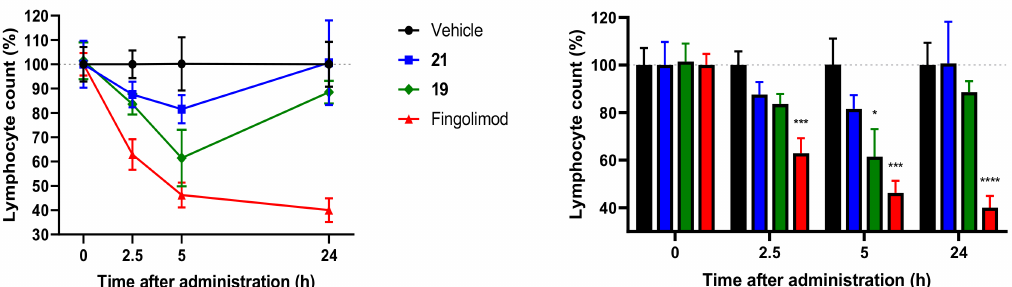
Figure 2. Reduction of the blood lymphocyte count by the treatment of 19 and 21 in mice. Mice were intravenously administered with the vehicle ( n = 8), 19 (15 mg/kg, n = 7), 21 (30 mg/kg, n = 10), or positive control fingolimod (3 mg/kg, n = 8). Blood lymphocyte counts were measured before (0 h) and after the administration (2.5 and 5, 24 h). Percentage of the lymphocyte count at the time before administration (0 h) was considered as a baseline (100%). * p < 0.05, *** p < 0.001, **** p < 0.0001 compared to vehicle-treated group (one-way ANOVA with Dunnett’s test). Data are presented as mean ±